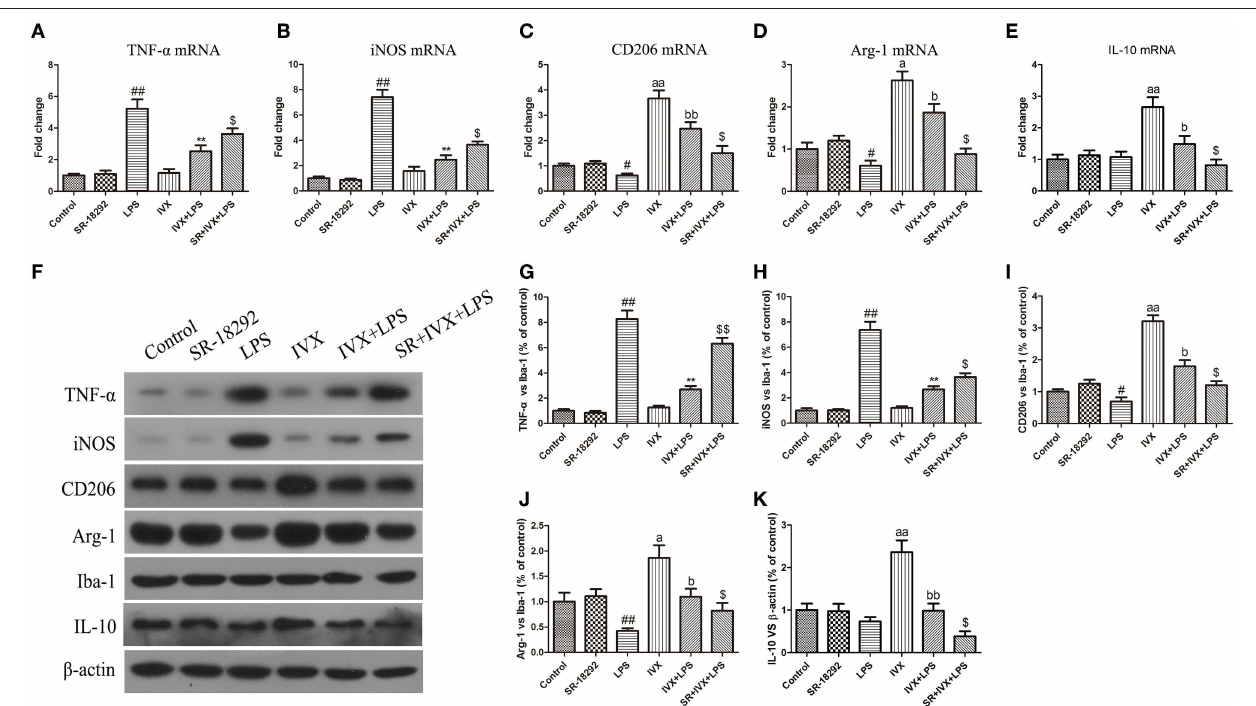
FIGURE 10 | IVX-mediated PGC-1 α activation inhibited M1 microglial polarization and promoted M2 microglial polarization in the cerebral cortices of LPS-injected mice. After the open field test, the cerebral cortices of mice were harvested. In LPS-injected mice, to investigate the effect of IVX-mediated PGC-1 α activation on microglial polarization, the mRNA and protein expression of M1 microglial markers (TNF- α and iNOS) and M2 microglial markers (Arg-1 and CD206) were tested via RT-PCR and western blotting. (A,B) The mRNA expression of M1 microglial markers (TNF- α and iNOS) were measured via RT-PCR. (C,D) The mRNA expression of M2 microglial markers (Arg-1 and CD206) was measured via RT-PCR. (F–H) The protein expression of M1 microglial markers (TNF- α and iNOS) were measured via western blotting. (I,J) The protein expression of M2 microglial markers (Arg-1 and CD206) was measured via western blotting. (E,K) The gene and protein expression of IL-10 was measured via RT-PCR and western blotting. The experiments were conducted in triplicate and repeated at least three times. Values are expressed as mean ± SEM ( n = 4–5 in each group). # p < 0.05 and ## p < 0.01, vs. control group; ** p < 0.01 vs. LPS group; $ p < 0.05 and $$ p < 0.01 vs. IVX + LPS group; a p < 0.05 and aa p < 0.01, vs. control group; b p < 0.05 and bb p < 0.05 vs. IVX